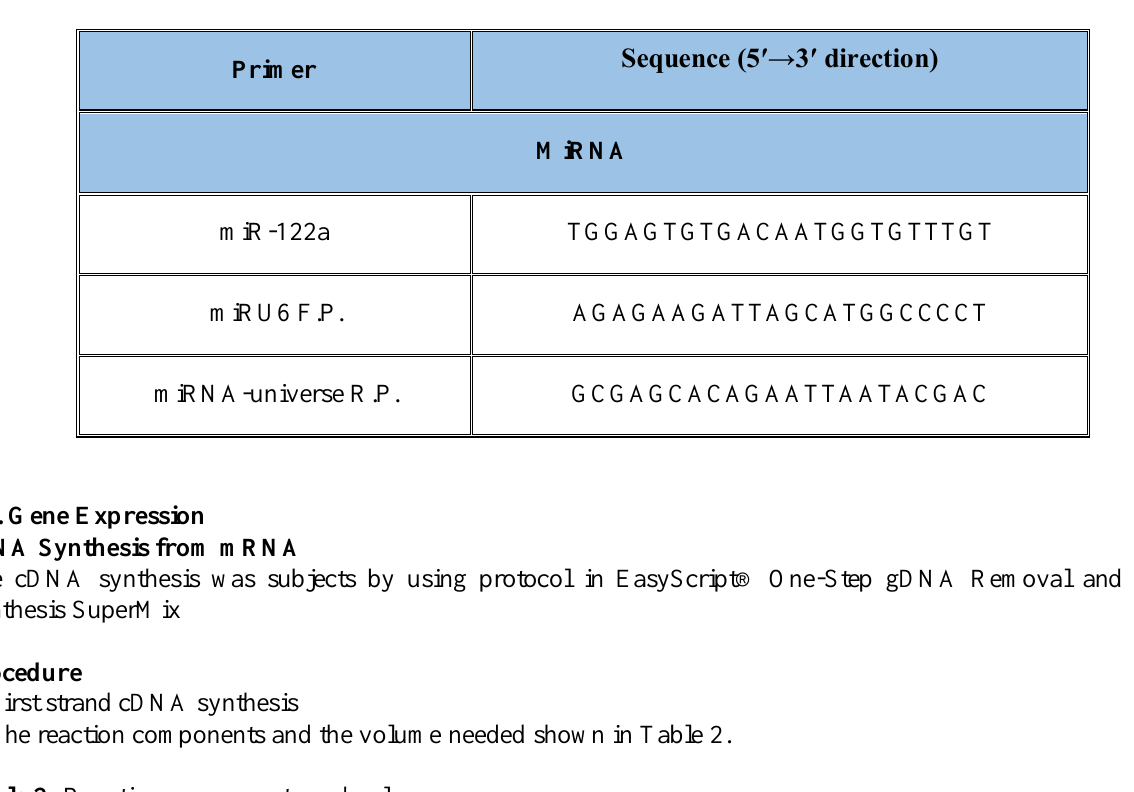
Table 1: Primers and their sequences.